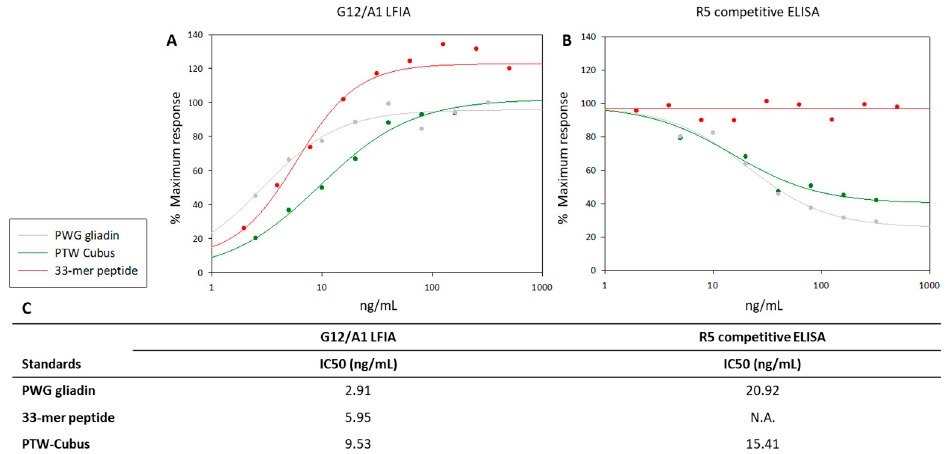
Figure 3. Relative affinity of G12/A1 LFIA and R5 competitive ELISA for different reference standards. ( A ) G12/A1 LFIA. ( B ) R5 competitive ELISA. ( C ) Standard reference curves. IC 50 and CR were obtained for G12/A1 LFIA and R5 competitive ELISA. The IC 50 is defined as the concentration of the line that reduces the peak absorbance by 50% in the assay. These assays were performed in duplicates. In the figure the gray points correspond to PWG-gliadin; the green points, PTW-Cubus; and the red dots, 33-mer peptide. LFIA, lateral flow immunochromatographic assays; N.A., not applicable.